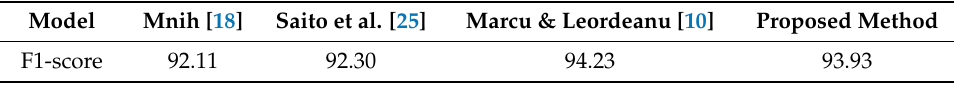
Table 4. Results on the testing data of Massachusetts aerial images in terms of F1score